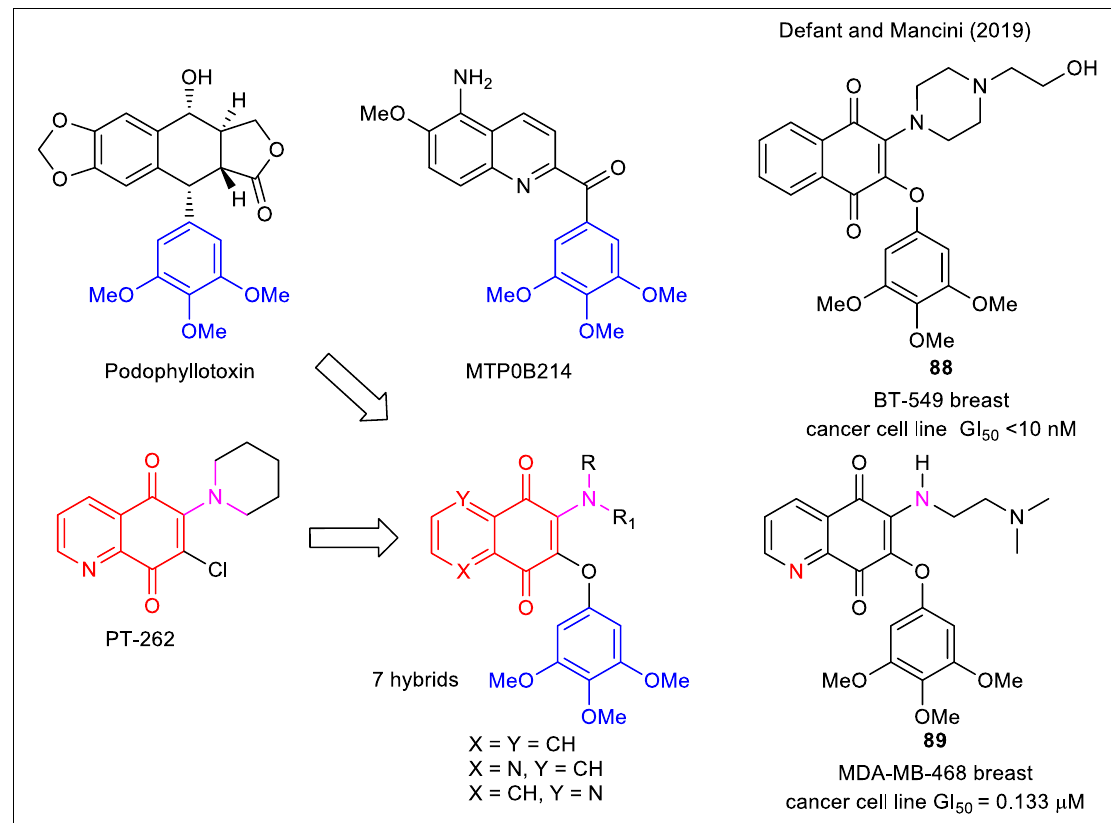
Figure 33. 1,4-Naphthoquine and quinolone-5,8-dione scaffolds in alkylamino-trimethoxyl hybrids as reported by Defant and Mancini